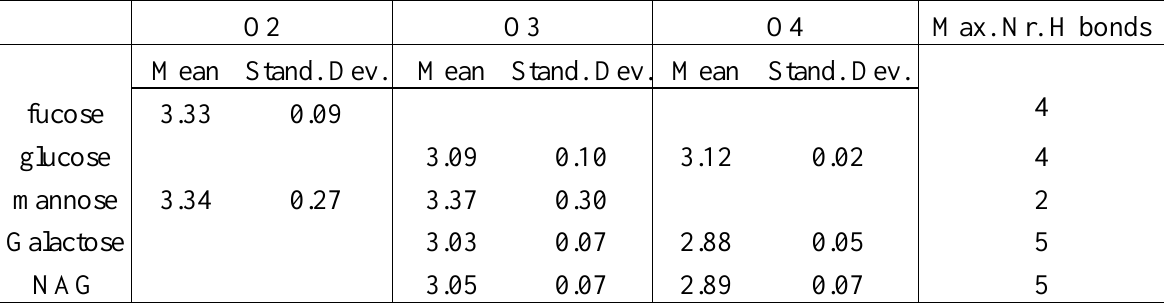
Table 1. Interatomic distances (Å ) between the calcium ion and the oxygen atoms of the ligands, and maximum number of H bonds for the three conformations of each ligand.